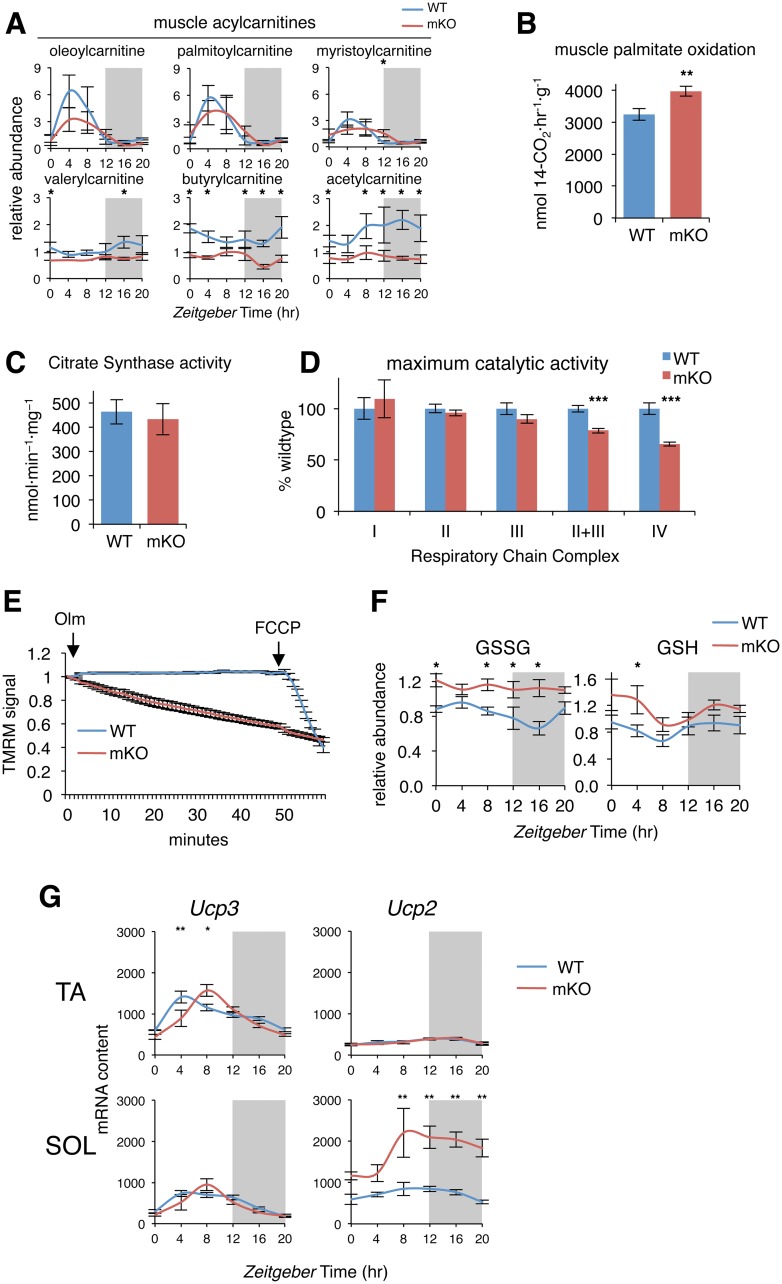
Increased lipid oxidative capacity yet reduced mitochondrial efficiency in mKO muscles.(A) Diurnal levels of selected acylcarnitines in TA muscles (mean ± SEM; n = 5 × group × time point; *p < 0.05, repeated measures ANOVA). (B) Palmitate oxidation in gastrocnemius homogenates (mean ± SEM; n = 12–13; **p < 0.01, Student’s t test). (C) CS activity in vastus lateralis muscle extracts (mean ± SEM; n = 18). (D) Maximum catalytic activity of Respiratory Chain Complex I (NADH:ubiquinone oxidoreductase; n = 6), Complex II (succinate dehydrogenase; n = 18), Complex III (decylubiquinol cytochrome c oxidoreductase; n = 18), Complex II+III (succinate cytochrome c reductase; n = 18), and Complex IV (cytochrome c oxidase; n = 18) in vastus lateralis muscle extracts (mean% relative to WT ± SEM; ***p < 0.001, Student’s t test). (E) Real-time fluorescence of isolated flexor digitorum brevis muscle fibers loaded with TMRM and imaged every 60 s; data expressed relative to initial fluorescence; 5 μM Olm and 4 μM FCCP were added where indicated (mean ± SEM; n = 21–24 fibers isolated from 5 animals per group). (F) Diurnal levels of GSSG and GSH in mKO and WT TA muscles (mean ± SEM; n = 5 × group × time point; *p < 0.05, repeated measures ANOVA). (G) Diurnal expression in TA and SOL muscles determined by microarray and plotted as absolute expression levels (n = 3 × time point; mean ± SEM *p = 0.05, **p = 0.01, 2-way ANOVA with Bonferroni correction). Underlying data can be found in supporting files S1 Data and at Gene Expression Omnibus (accession number GSE43071). CS, citrate synthase; FCCP, carbonylcyanide-p-trifluoromethoxyphenyl hydrazone; GSH, reduced glutathione; GSSG, oxidized glutathione; mKO, myocyte-specific loss of BMAL1; Olm, oligomycin; SOL, soleus; TA, tibialis anterior; TMRM, tetramethylrhodamine methyl ester; WT, wild type.